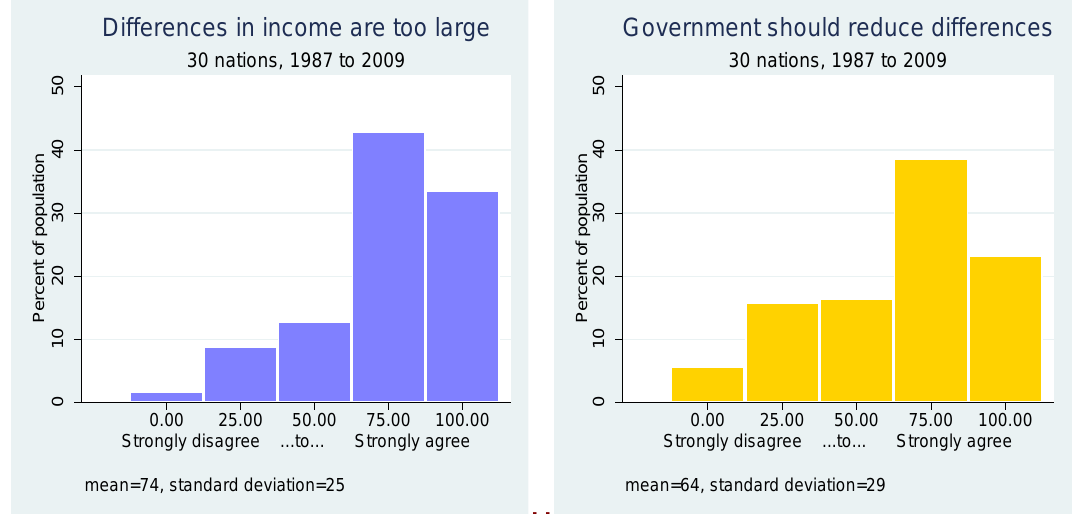
Figure 11. Percent distributions for the 2 items in the redistribution attitudes scale.